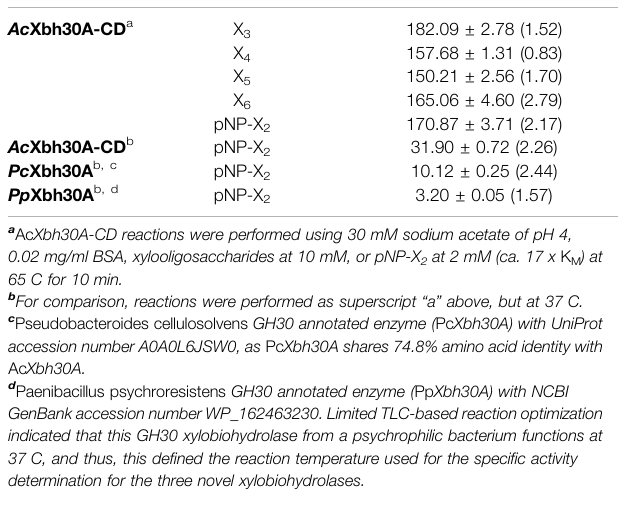
TABLE 1 | Speci fi c activity measurements of Ac Xbh30A-CD and homologous enzymes. Enzyme Substrate